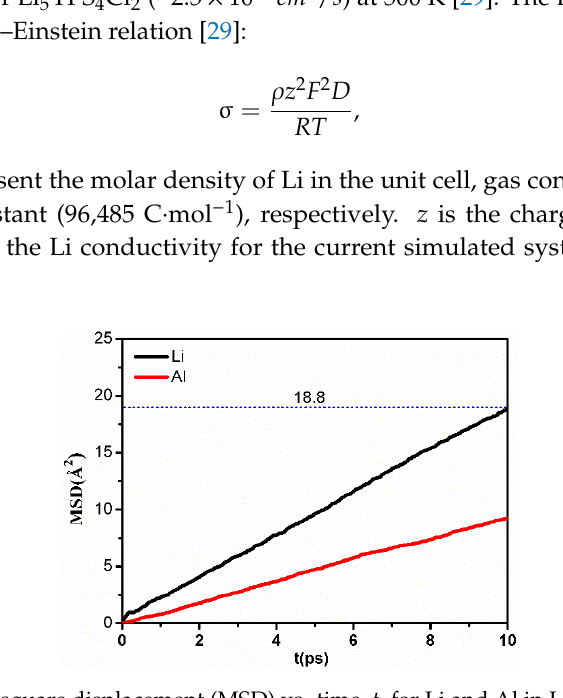
Figure 5. The mean square displacement (MSD) vs. time, t , for Li and Al in LiAl 2 (OH) 6 Cl at 500 K.